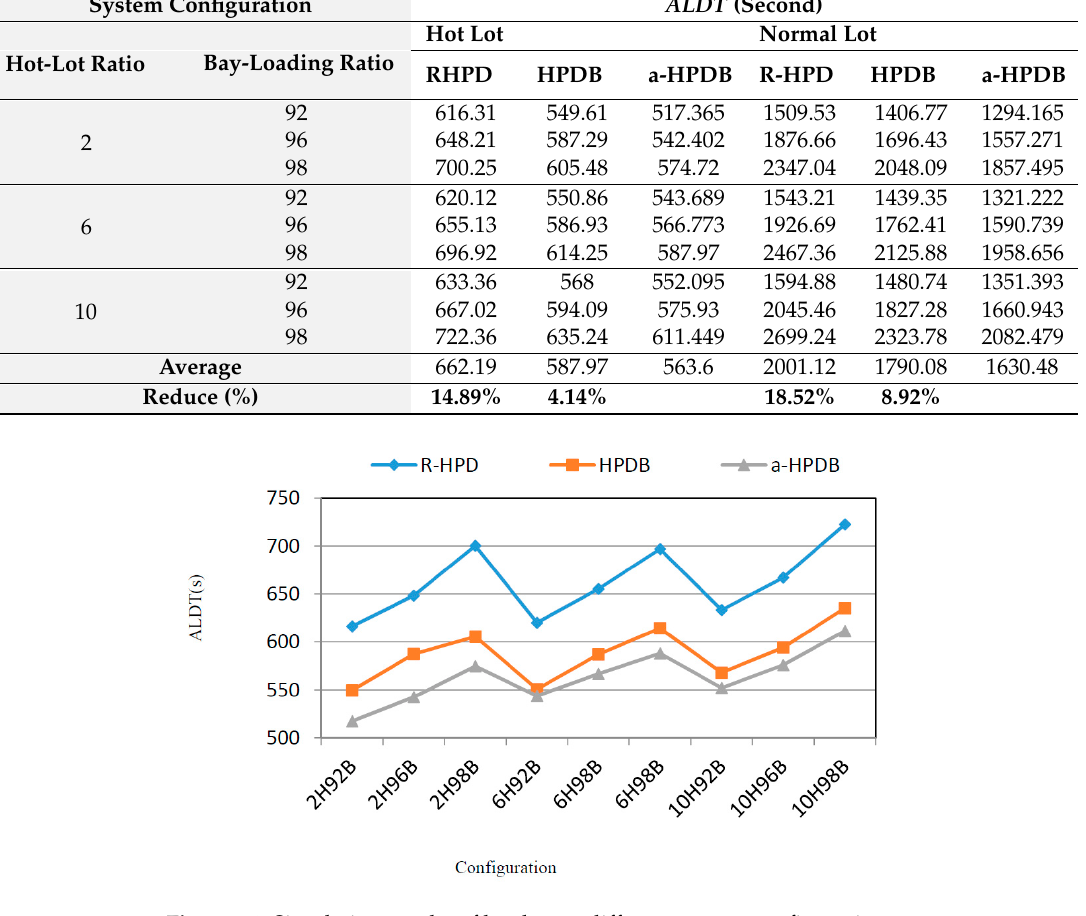
Figure 14. Simulation results of hot lots at different system configurations.